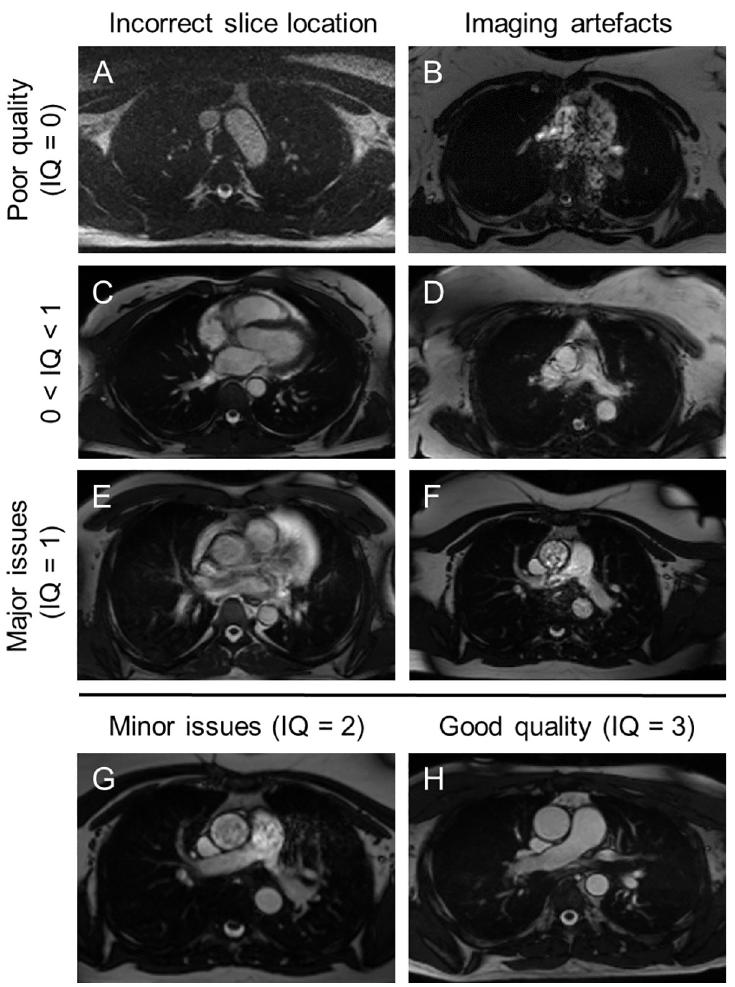
Fig 1. Example images with different image quality (IQ) scores. Poor quality (IQ = 0) due to incorrect slice location (A) and extreme imaging artefacts (B). 0 < IQ < 1 due to incorrect slice location (C) and severe artefacts (D). Major issues (IQ = 1) due to slice location (E) and artefacts (F). Example images with (G) minor issues (IQ = 2) and (H) good quality (IQ = 3). Please refer to the methods section in the main text for their definitions.